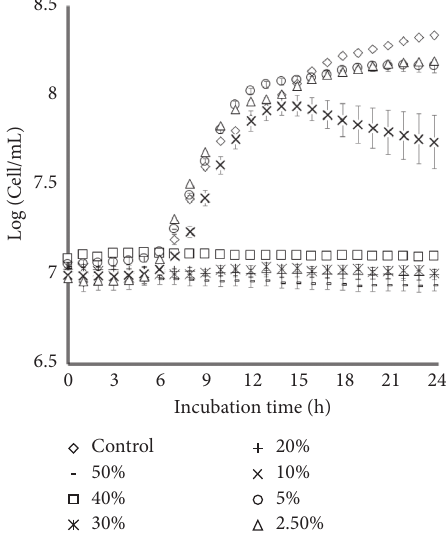
Figure 2: Effect of NJ on the growth of E . coli in vitro at different concentrations. Table 1: Kinetic parameters of E . coli in vitro treated with NJ at different